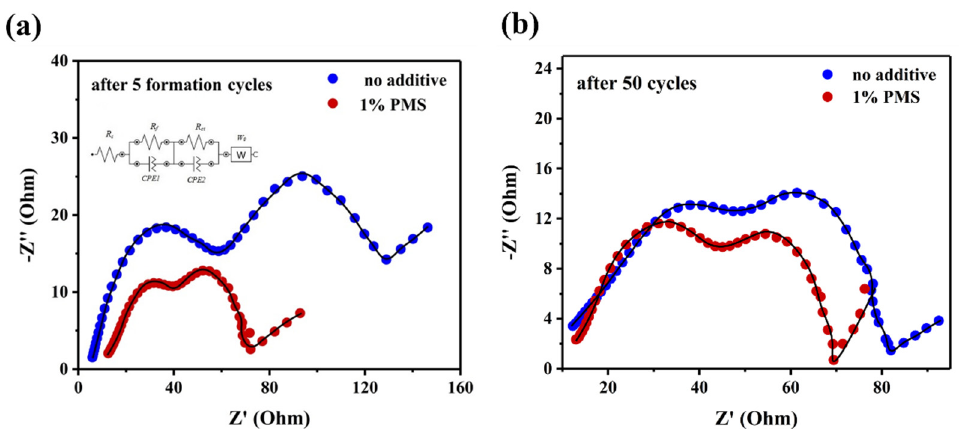
Figure 2. The Nyquist plots of Li/G half-cells without and with 1% PMS after ( a ) 5 cycles 0.5 C as the formation, and ( b ) after 50 cycles 1 C. The equivalent circuit model used for simulating experimental results is inserted in Figure 2a (From left to right, R s , R f , R ct , CPE, and W 0 denote resistance of solution, interfacial layer resistance, charge transfer resistance, constant phase resistance, and Warburg impedance, respectively). Table 2. EIS fitting results of the Li/graphite half-cells using electrolytes without and with 1 wt% PMS after 5 cycles 0.5 C as formation and 50 cycles 1